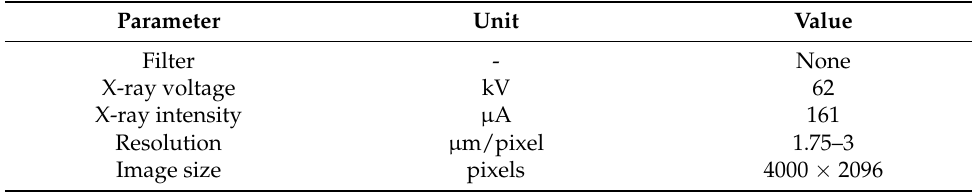
Table 4. Micro-CT scanning parameters.